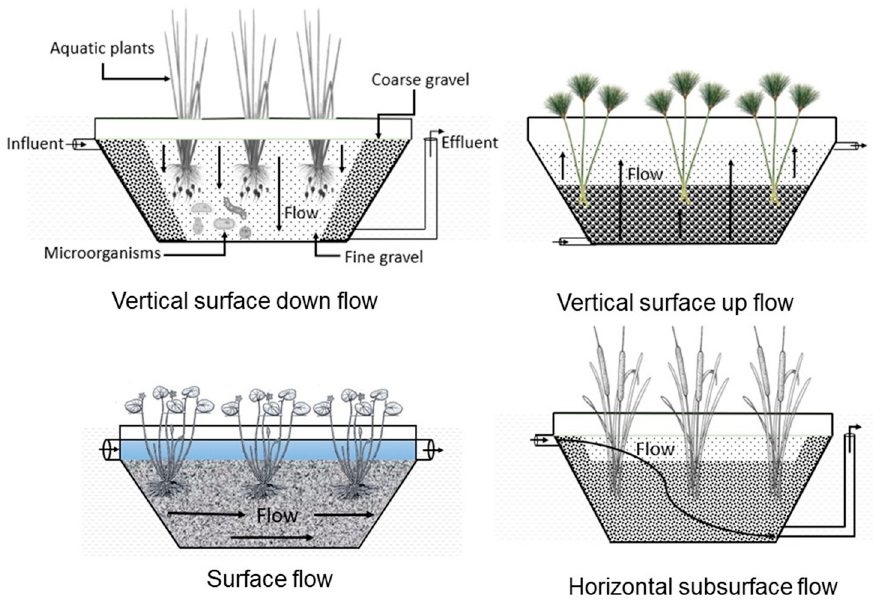
Figure 3. Scheme for flow configuration, type of support, and type of macrophyte in the constructed